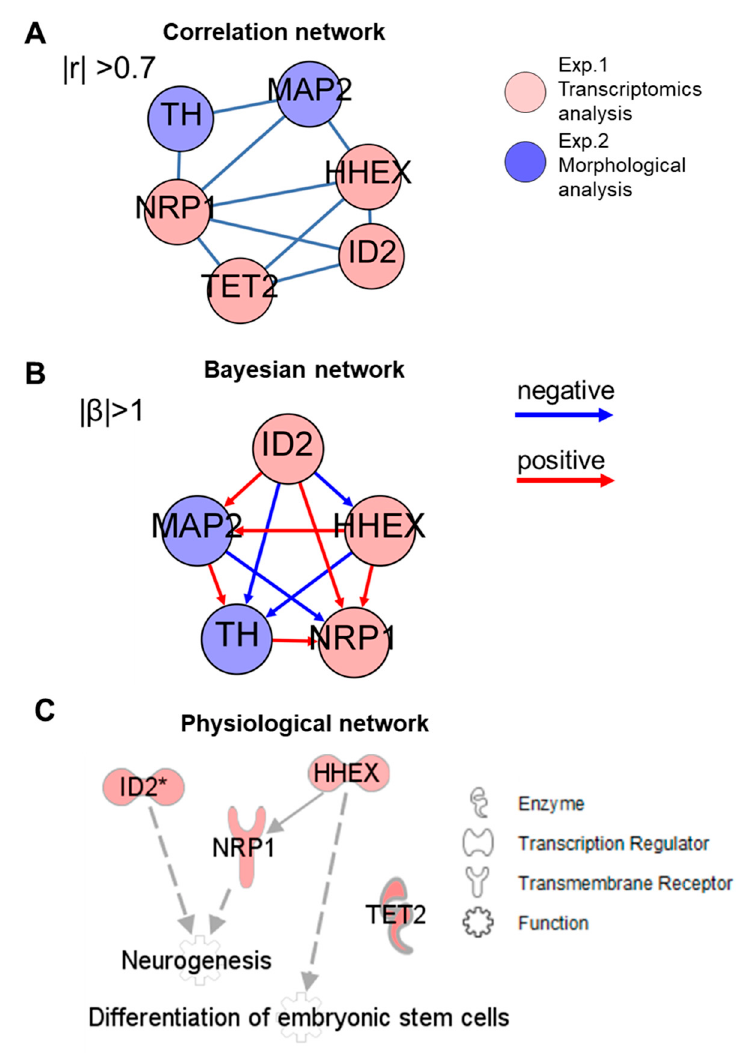
Figure 4. Integrated network analysis of transcriptomic and morphological changes during neuronal di ff erentiation from hESC-derived spheres. ( A ) Pearson correlation analysis. The links with an absolute Pearson correlation coe ffi cient of more than 0.7 are shown. The network was visualized using Gephi software. ( B ) Bayesian network analysis. The network was generated based on the TAO-Gen algorithm using the web-based RX-Taogen software and was visualized using Gephi software. The β -value of the Bayesian model is expressed as a red arrow if positively relative ( β > 1), and a blue arrow if negatively relative ( β < 1). ( C ) Physiological network generated using the Ingenuity Knowledge Base of the IPA software. Upregulated genes induced by TMD exposure are indicated in red symbols that are representing molecules. The solid line indicates direct interactions gene-gene association. Dot lines indicate indirect interactions to “Neurogenesis” or “Di ff erentiation of embryonic stem